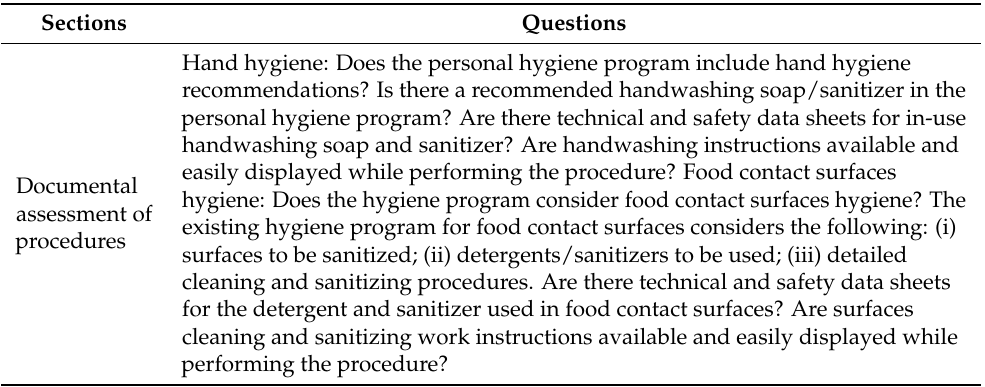
Table A1. Checklist sections, sub-sections, and evaluated